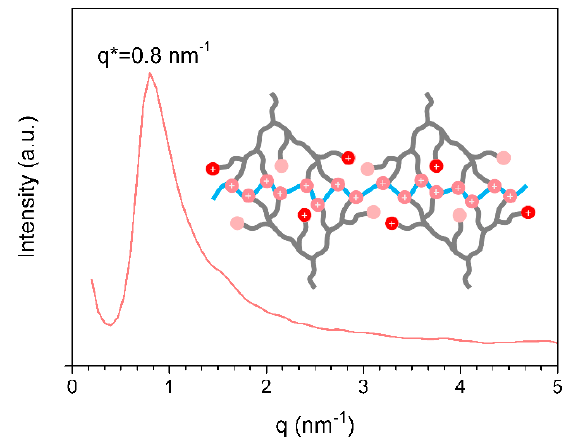
Figure 4. Small-angle X-ray scattering (SAXS) profile for membrane C-HBM-1.78 measured at room temperature under dry state (the insert is the schematic chemical structure of C-HBM-1.78).